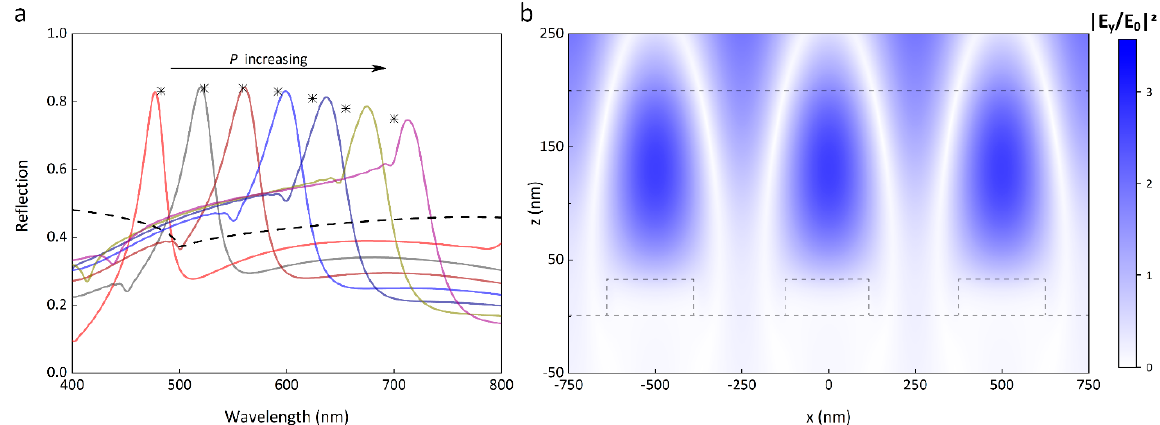
Figure 2. ( a ) The simulated reflection spectra for the grating period P from 400 nm to 700 nm with a step size of 50 nm. For the waveguide coating, the refractive index n is fixed to 1.5, and the thickness t is set at 200 nm. The dashed line represents the reflection spectrum of the grating array ( P = 500 nm) without waveguide coating. The asterisks are the analytical resonance wavelengths calculated by Equation (3). The analytical parameters are the same as numerical ones except for φ metal = π for simplicity. ( b ) The electrical field intensity profile at XZ plane for the guided mode resonance at 564 nm. P = 500 nm, t = 200 nm.